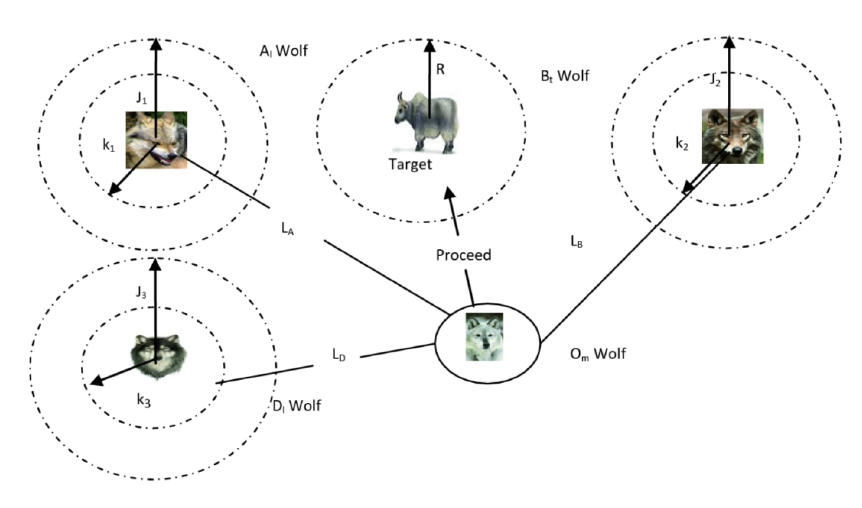
Fig. 4. The position and explanation of wolves defined in GWO